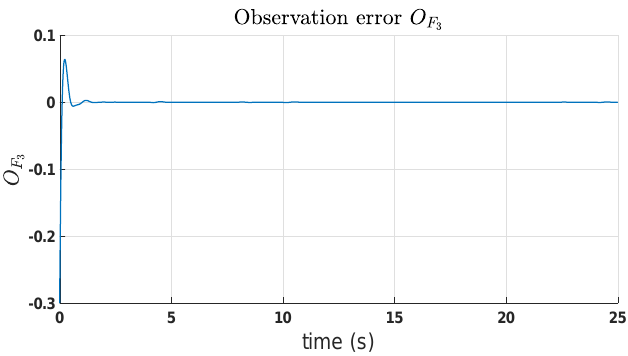
Figure 15. Observation error dynamics O F